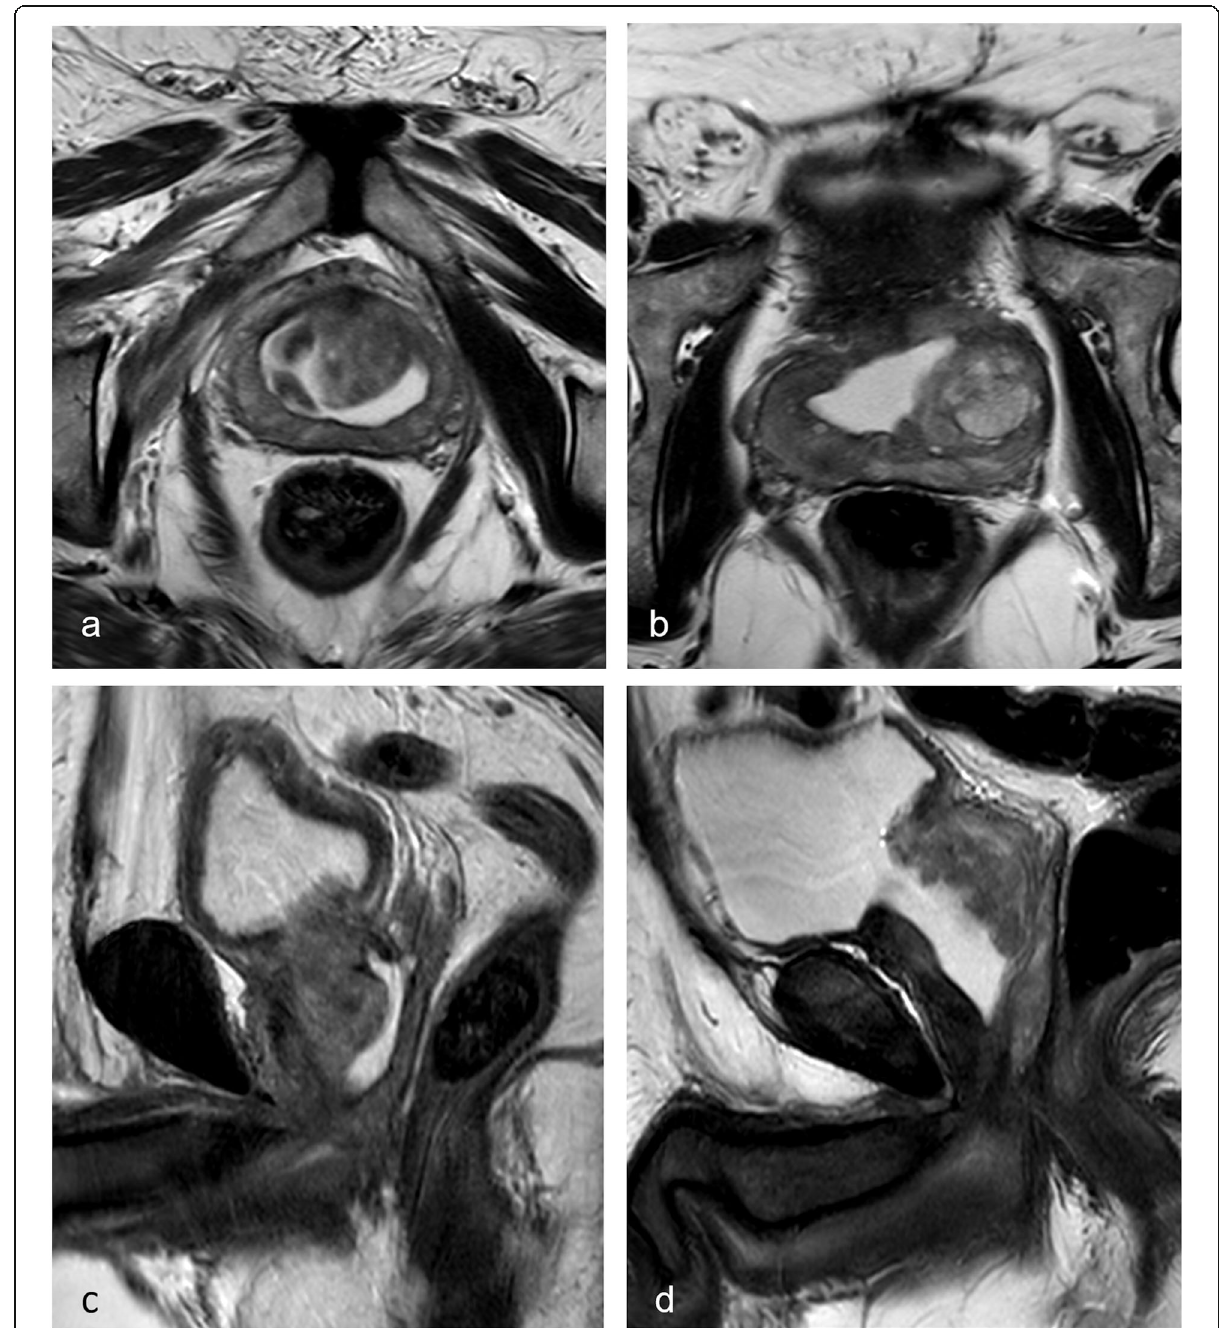
Fig. 4 T2-weighted sequences along the axial ( a ) and sagittal ( c ) plane at month 12 after transperineal prostate laser ablation (TPLA) in a 70-year- old patient in comparison with the same sequences ( b , d ) in a 68-year-old patient 12 months after transurethral resection of the prostate (TURP). After TPLA, a horseshoe-shaped hyperintense fluid collection in the transitional gland is well emarginated by the prostate pseudocapsule. The urethra is visible as a hyperintense spot inside the solid stromal adenoma core with reduced compression from the hypertrophic central gland. Both bladder neck and urethra morphology are preserved and therefore bladder function and ejaculation are preserved as well. After transurethral resection of the prostate (TURP), the bladder neck is wedged into the surgical cavum. The urethra is no longer visible. Bladder function and ejaculation are